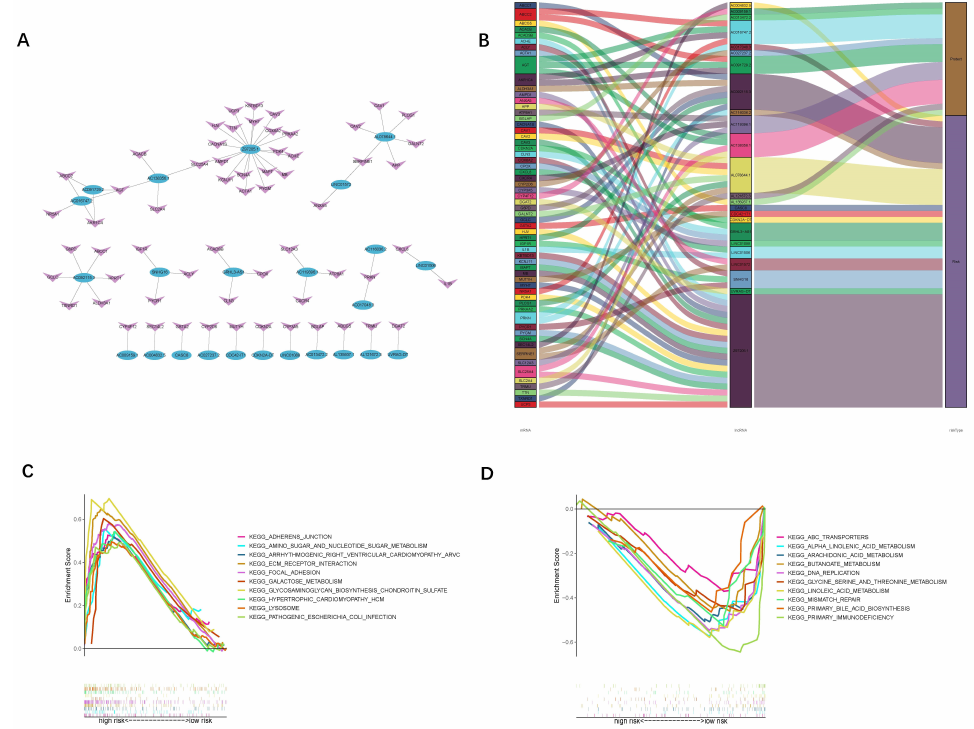
Figure 5. The KEEG and GO analyses of differential genes between the low- and high-risk groups. ( A , C , E , G ): KEGG analysis of the differentially expressed genes in two groups. ( B , D , F , H ): GO anal- ysis of the differentially expressed genes in two groups.